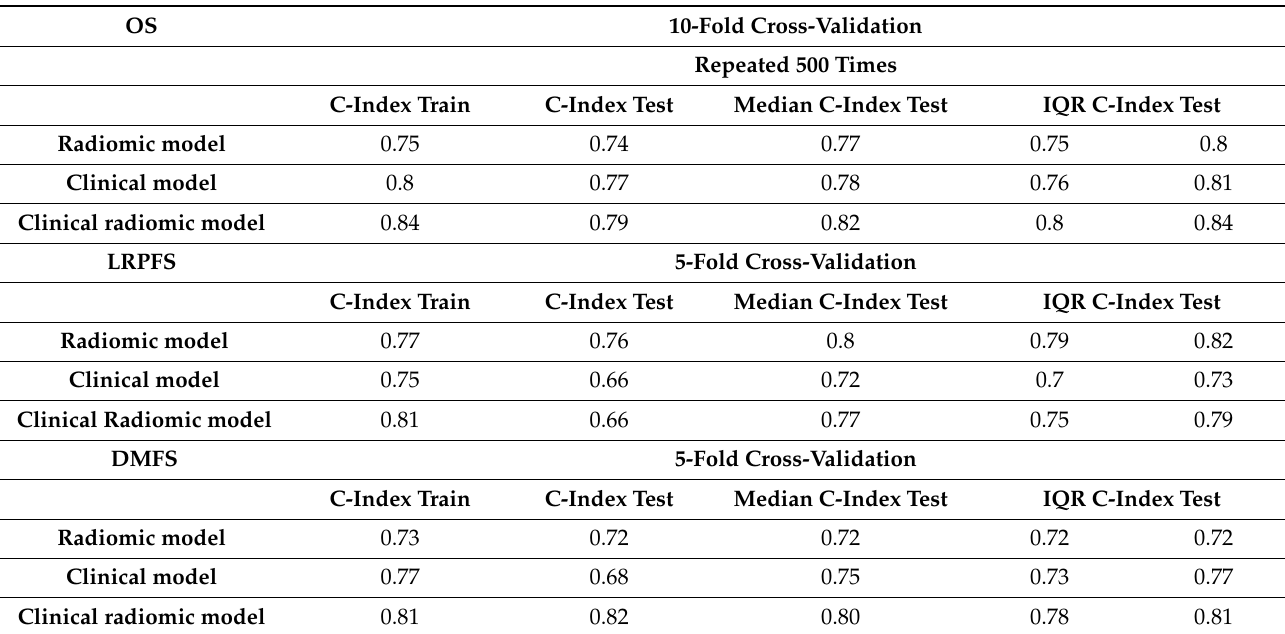
Table 3. Summary of the model performances for the whole population.